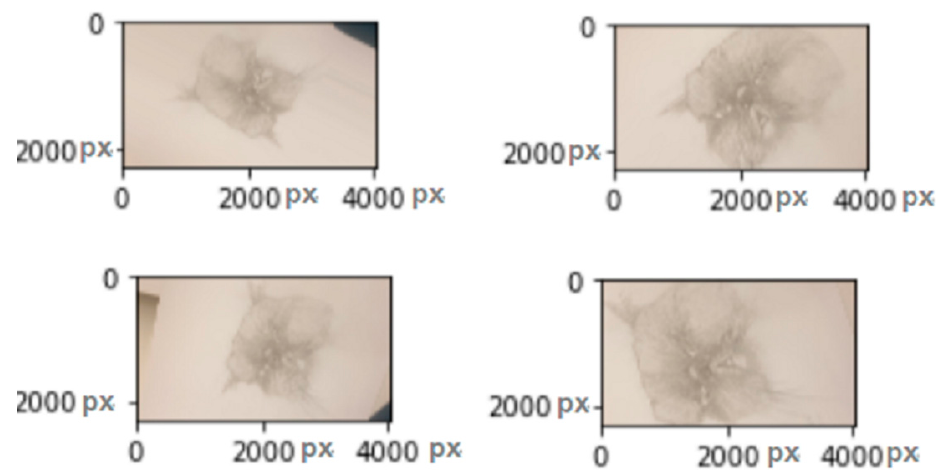
Figure 1. Number of trained images per class.